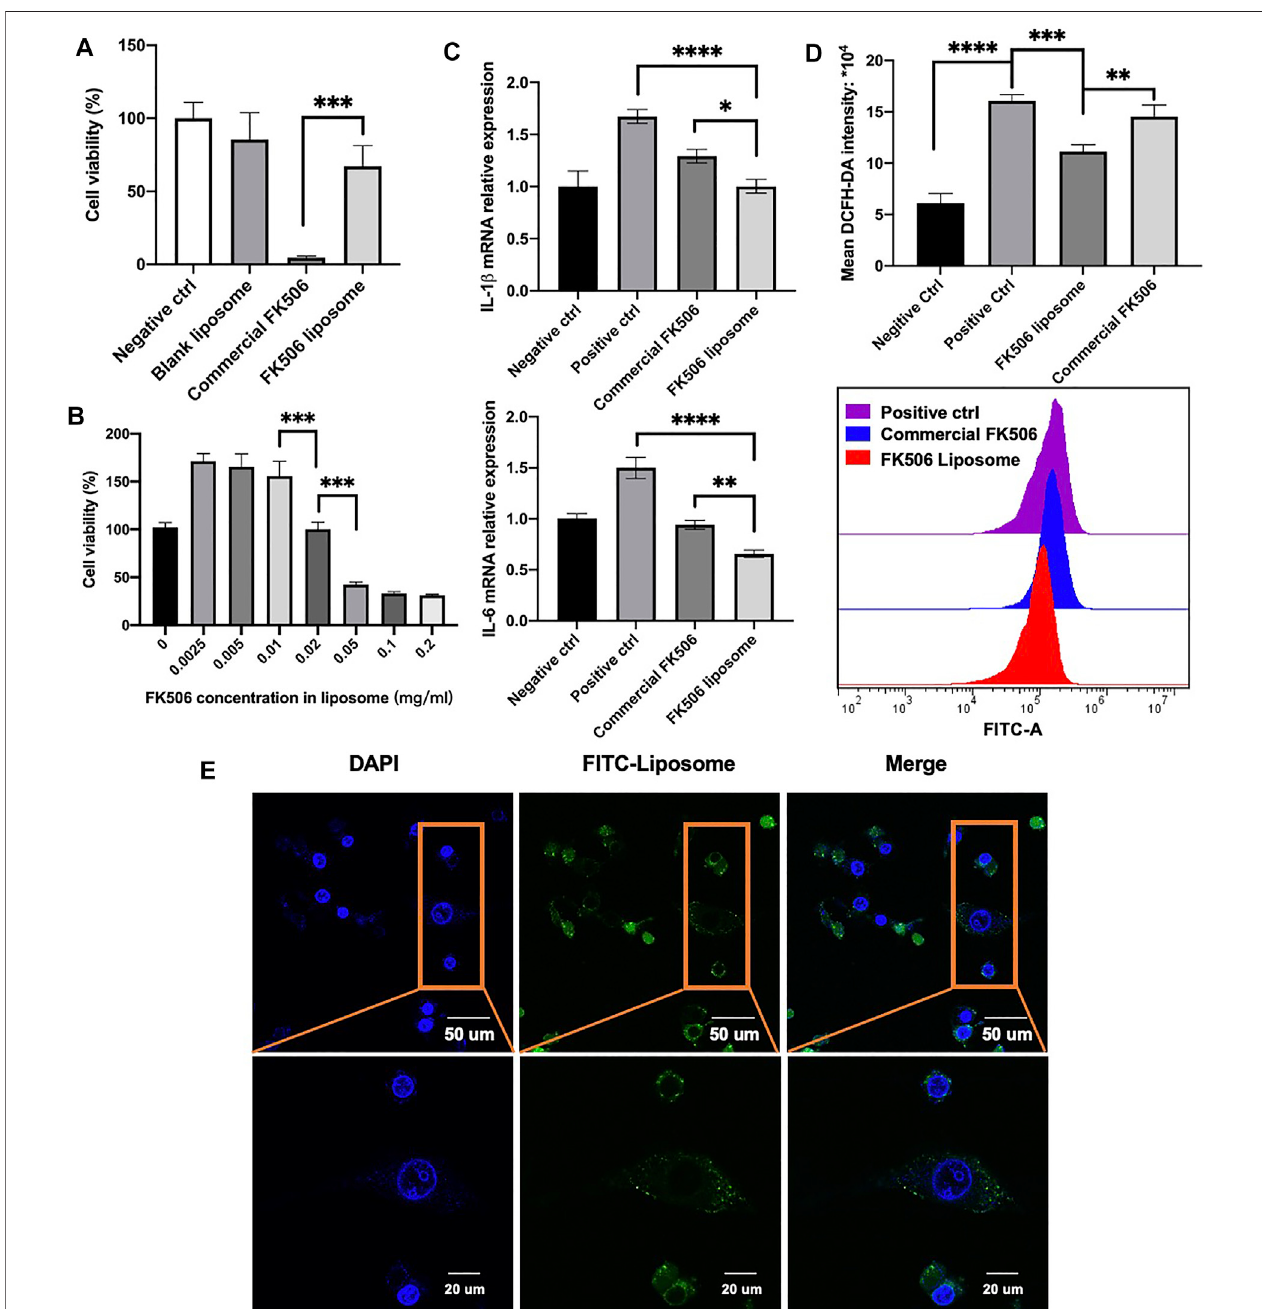
FIGURE 2 | In vitro cytotoxicity test and ef fi ciency evaluation on HCECs. (A) Cell viability test via CCK-8. HCECs were treated in a 0.2-mg/ml concentration of FK506 for 2 h ( n = 5). (B) Cell viability test of a gradient of FK506 concentration in liposomes. HCECs were treated for 24 h ( n = 4). (C) mRNA expression level of in fl ammation-related factors in the cornea and conjunctiva tissues after receiving different treatment. IL-1 β is shown in the upper image ( n = 3), and IL-6 is shown in the lowerimage( n =3). (D) FlowcytometryanalysisofROSlevel( n =3).* p < .05,** p < .01,and*** p < .001. (E) Co-localizationofFK506liposomesandHCECs.Thecell nucleus is stained blue, and the FK506 liposome is stained